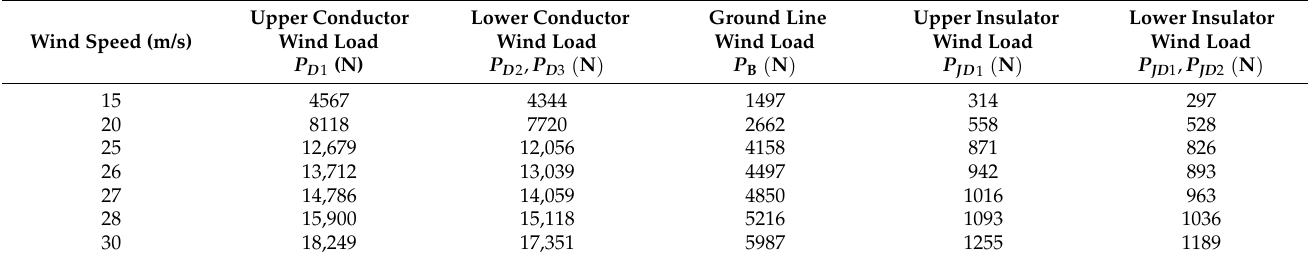
Table 4. Wind loads on the conductor, ground line, and